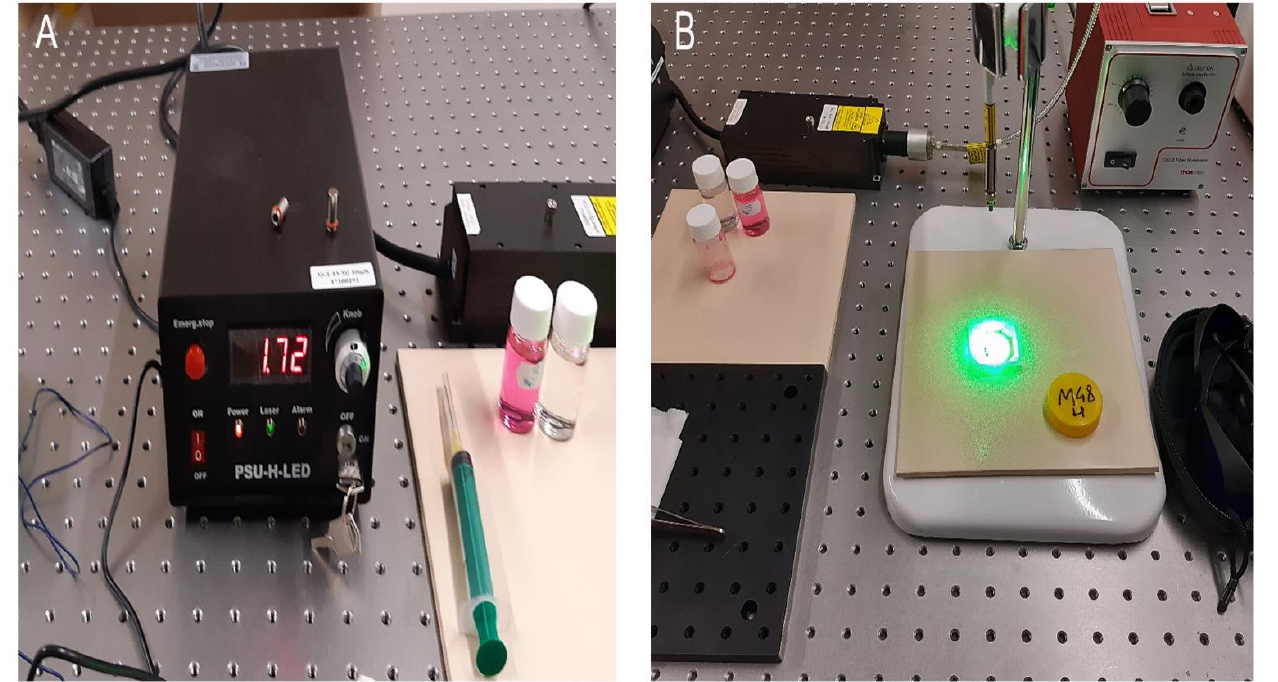
Figure 3. Experimental setup for in vitro irradiation of prostate tissue. Image ( A ) shows an image of the laser power source. Image ( B ) shows irradiation of a prostate cancer tissue sample with laser light.